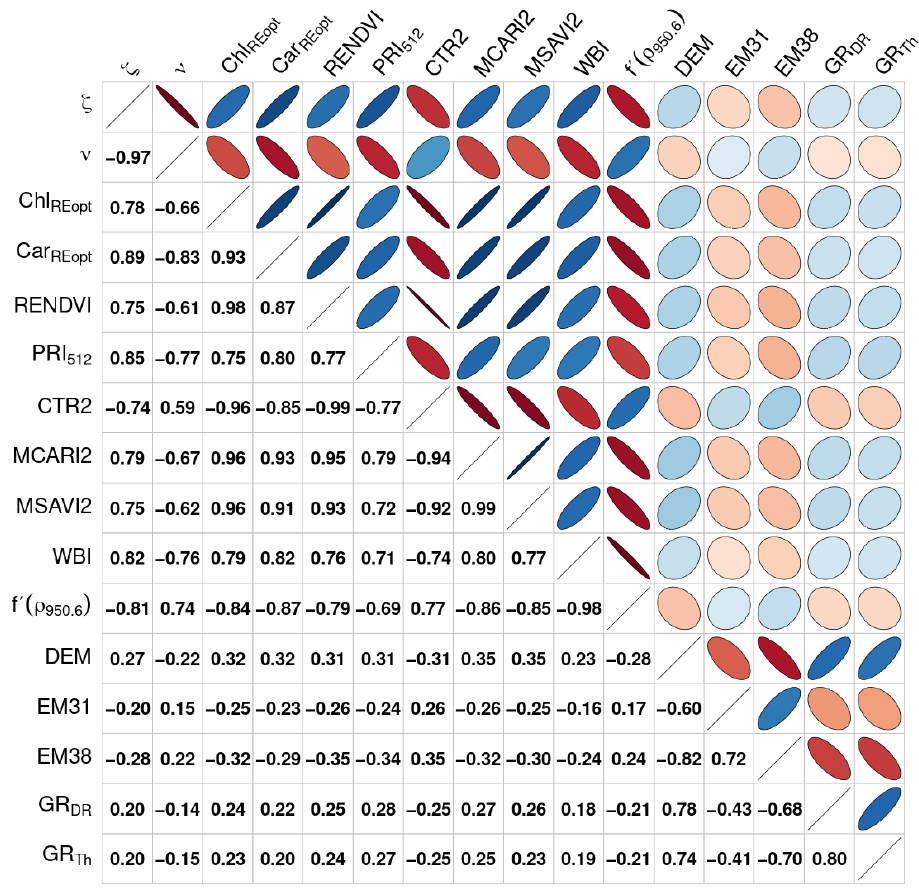
Figure 6. The correlation matrix of stress metrics ζ , ν and the evaluation dataset, which includes spec- tral indices, geophysical measurements and a digital elevation model (DEM). All of the correlations are highly significant ( p <